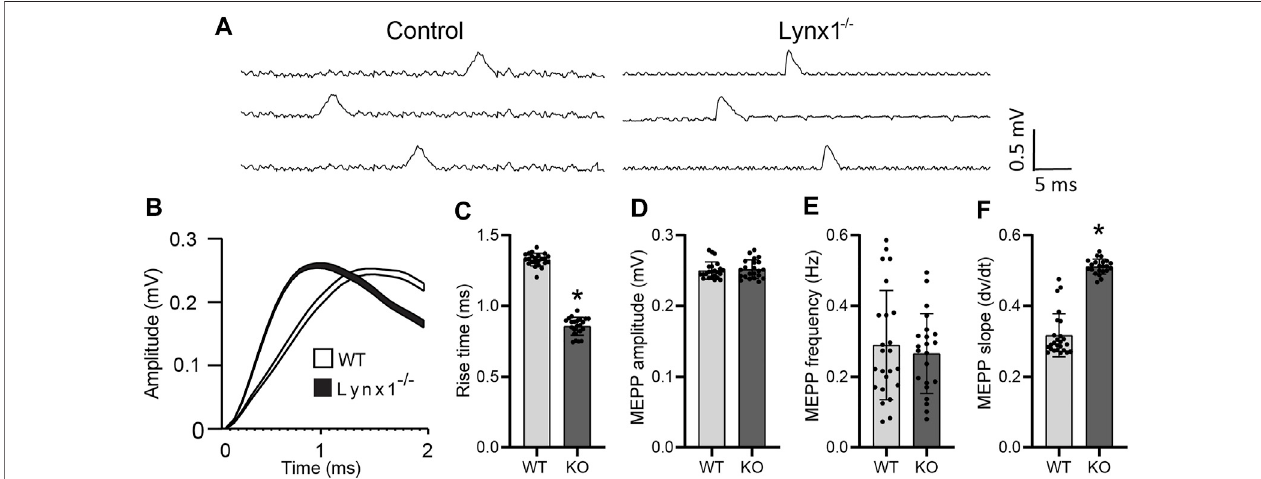
FIGURE 3 | Lynx1 deletion increases nAChR sensitivity. (A) Example traces of spontaneous miniature endplate potential (MEPP) recordings from control and Lynx1 − / − extensordigitorumlongus(EDL). (B) TheaverageMEPPamplitudeofcontrolandLynx1 − / − muscle,wherethelinewidthrepresentstheSEMof100recordings. (C) The average rise time to peak amplitude of MEPPs represented in (B) . (D) The mean amplitude of MEPPs in control and Lynx1 − / − muscle. (E) The frequency of MEPPsincontrolandLynx1 − / − muscle. (F) TheaverageslopeofMEPPstopeakamplitudein (B) .Control n ≥ 5,Lynx1 − / − n ≥ 8.Allvaluesaremean±SD.* p < 0.05, unpaired, two-tailed Student ’ s t